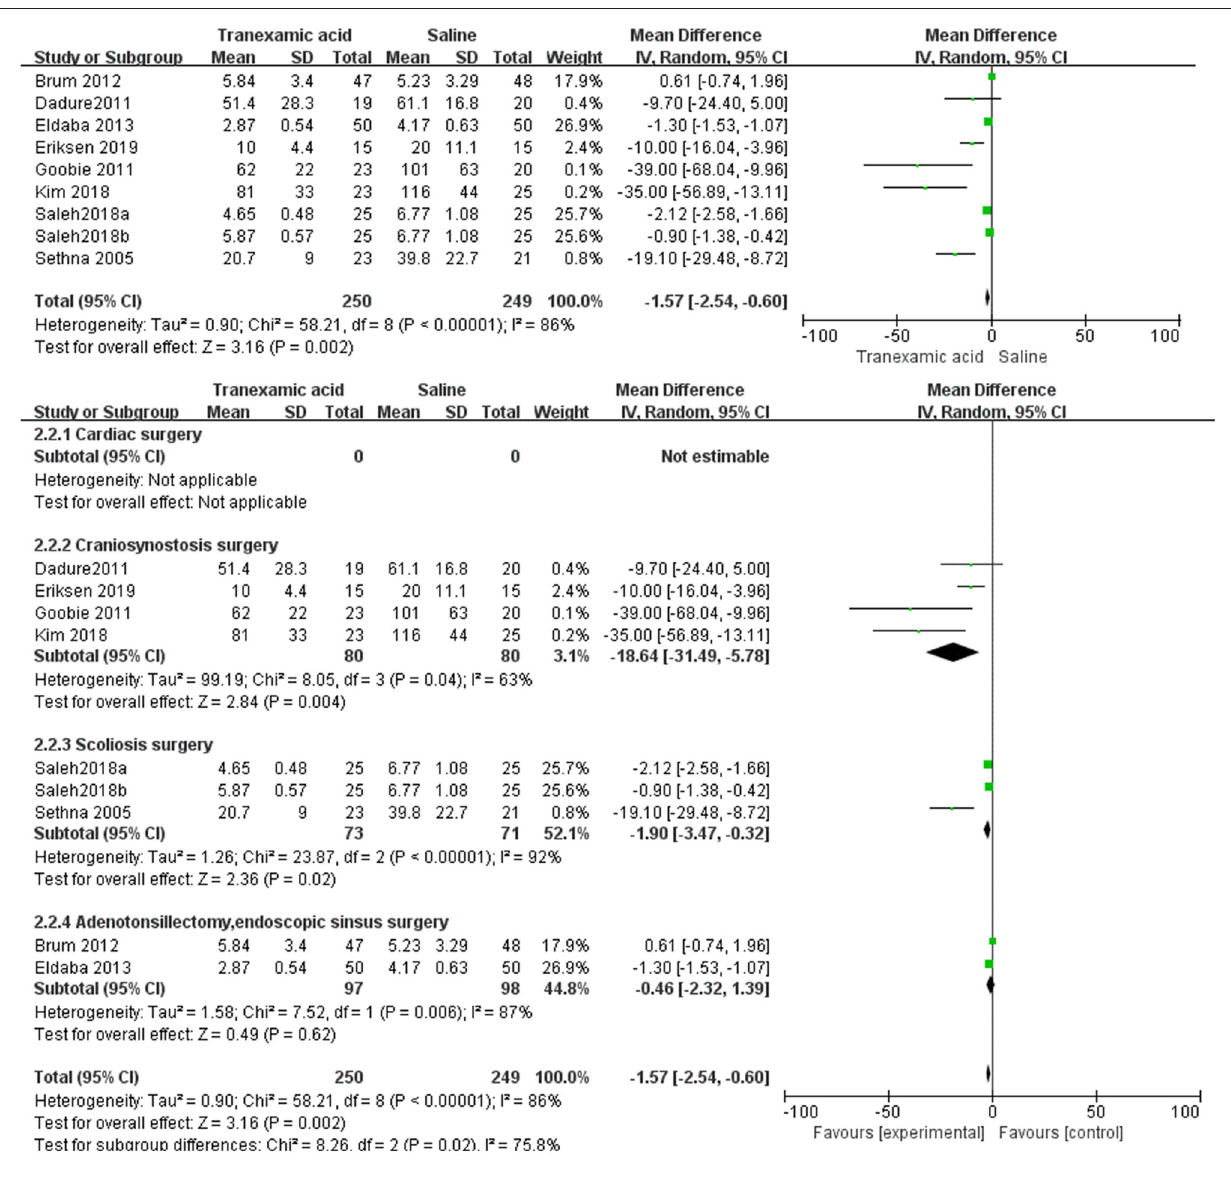
FIGURE 3 | Meta-analysis of intraoperative blood loss for TXA compared with